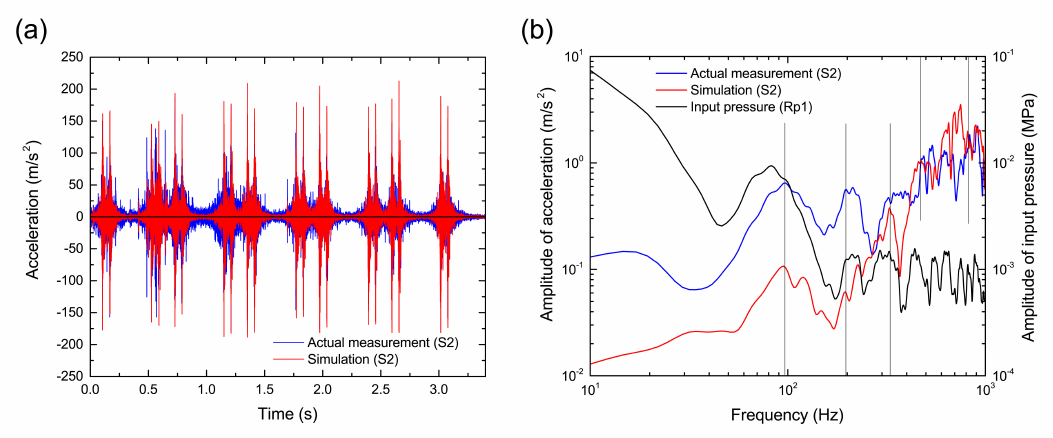
Figure 9. Comparison between numerical simulation and actual measurement in terms of vibration properties of sleeper at sensor position S2. ( a ) Time variation of sleeper acceleration in the vertical direction and ( b ) linear spectra of the sleeper acceleration. For reference, the linear spectrum of the input pressure loading, as shown in Figure 5, is also shown in (b). The linear spectra are smoothed by applying a Parzen window with a bandwidth of 20 Hz.